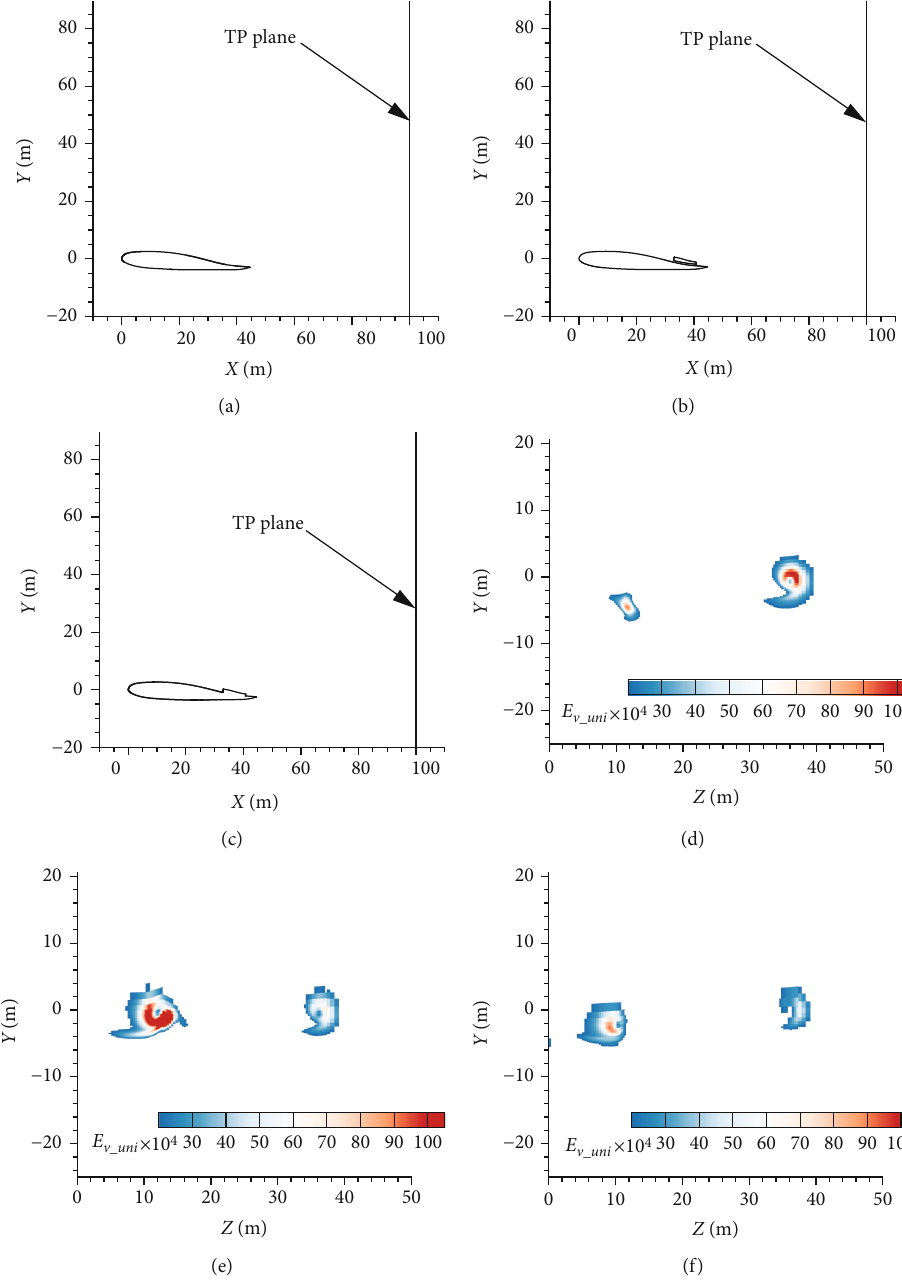
C , C , and C . (a – c) TP plane positions. (d – f) E v 0 1 2